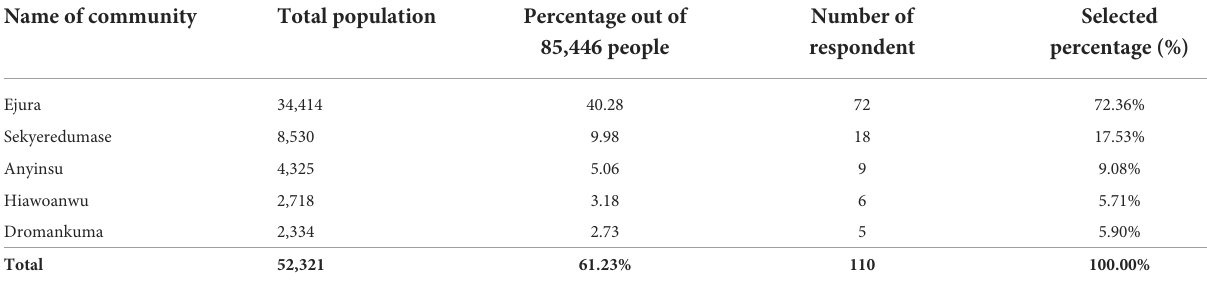
TABLE 1 Respondent selection distribution